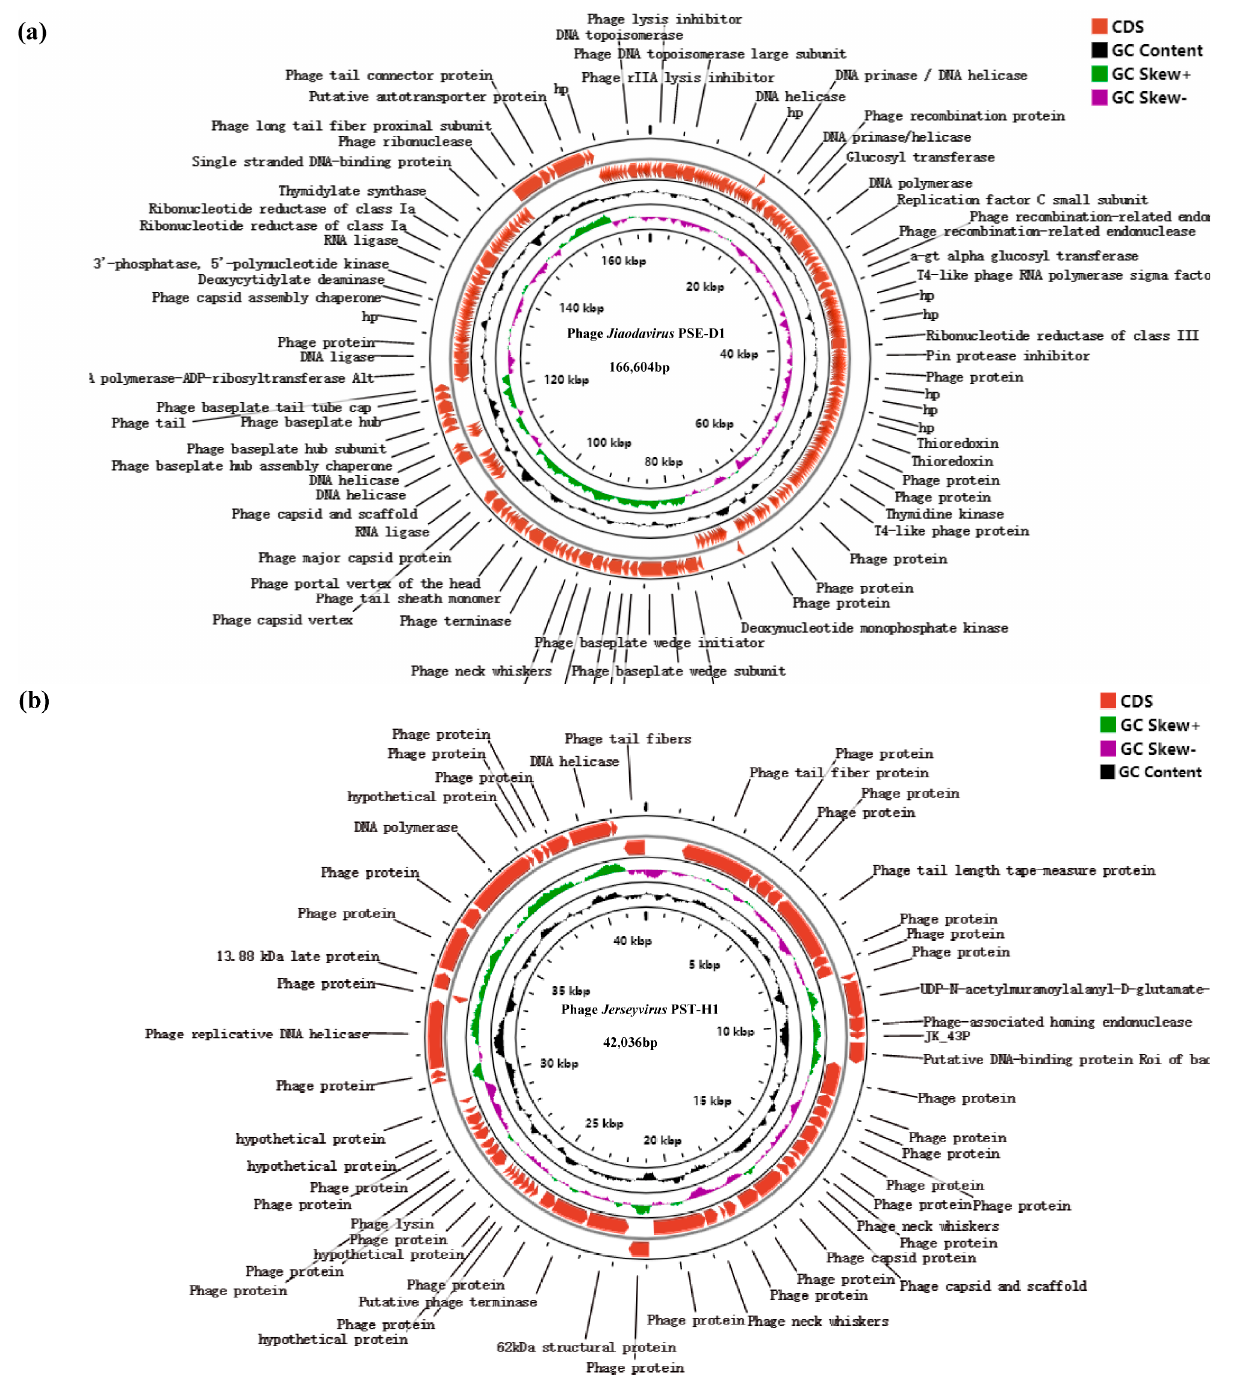
Figure 6. Comparative circular genome maps of phages. ( a ) phage PSE-D1. ( b ) phage PST-H1. Black represents GC content; green and purple represent positive and negative GC skew.